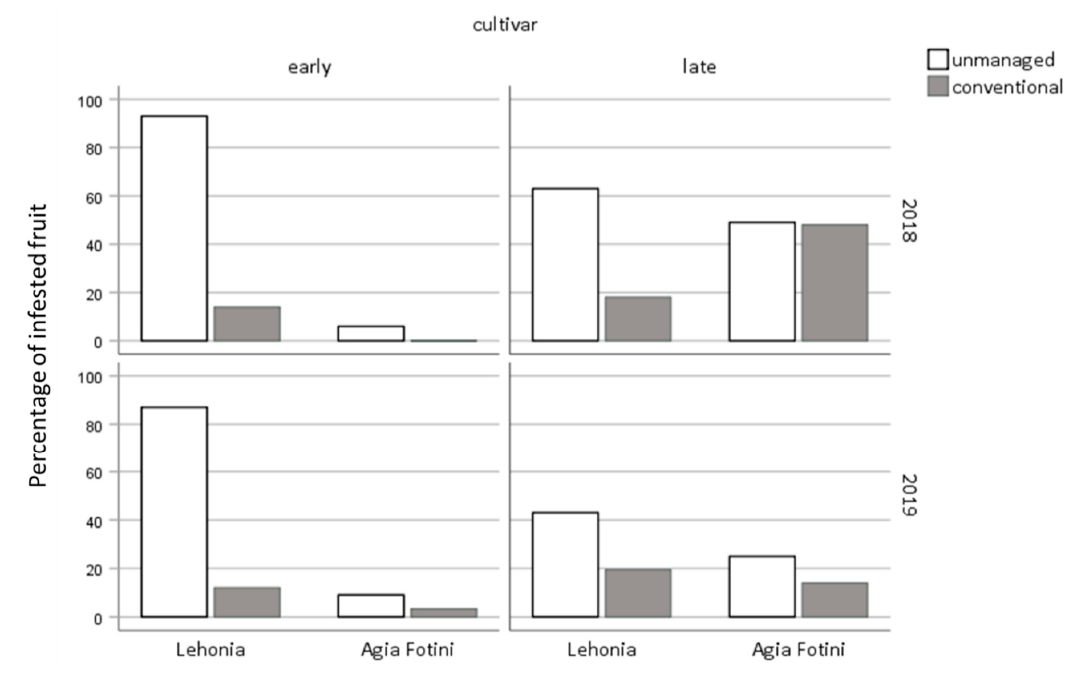
Figure 8. Sweet cherries infestation rates, sampled from early- and late-ripening cultivars of unmanaged and conventionally treated cherry orchards, located in Lehonia and Agia Fotini during 2018 and 2019. Table 5. Variables of the GLMs with significant effects on the cherry infestation levels and the number of adult Drosophila suzukii emerging from infested cherries.